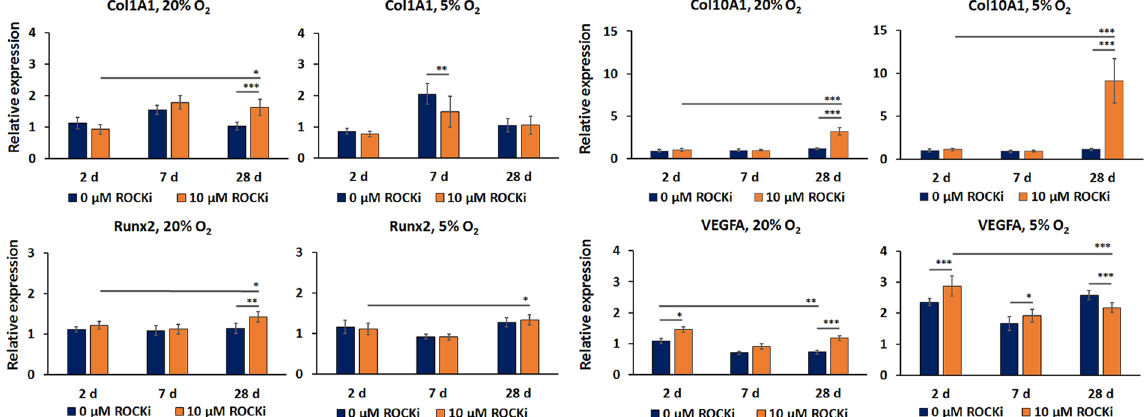
Figure 6. Relative gene expression of type I collagen, type X collagen, Runx2 and VEGFA at 2, 7 and 28 days of exposure to Y-27632 at normoxia and at hypoxia. The columns describe the mean ± 95% confidence intervals, n = 3 with two replicates. ( * p ≤ 0.05, ** p < 0.01, *** p <